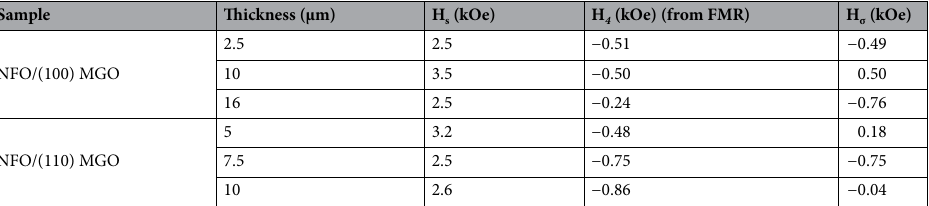
Table 3. Saturation magnetic field H s for out-of-plane hysteresis loops, magneto-crystalline anisotropy determined from FMR (Table 4), and growth induced anisotropy field H σ determined from magnetization versus magnetic field data for NFO films on (100) and (110) MGO substrates with different thickness.